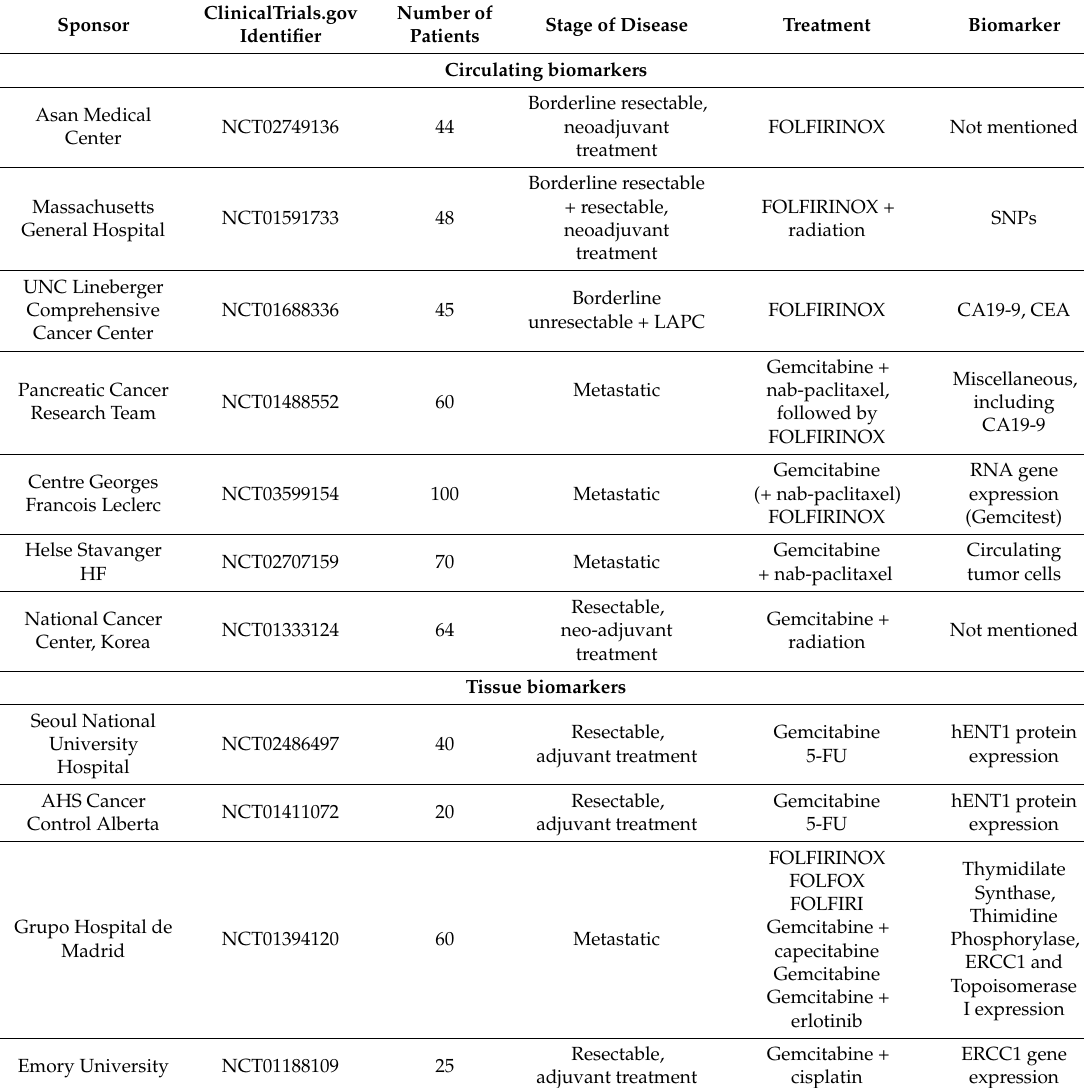
Table 4. Overview of PDAC clinical trials and the biomarkers to be investigated, registered at (www.